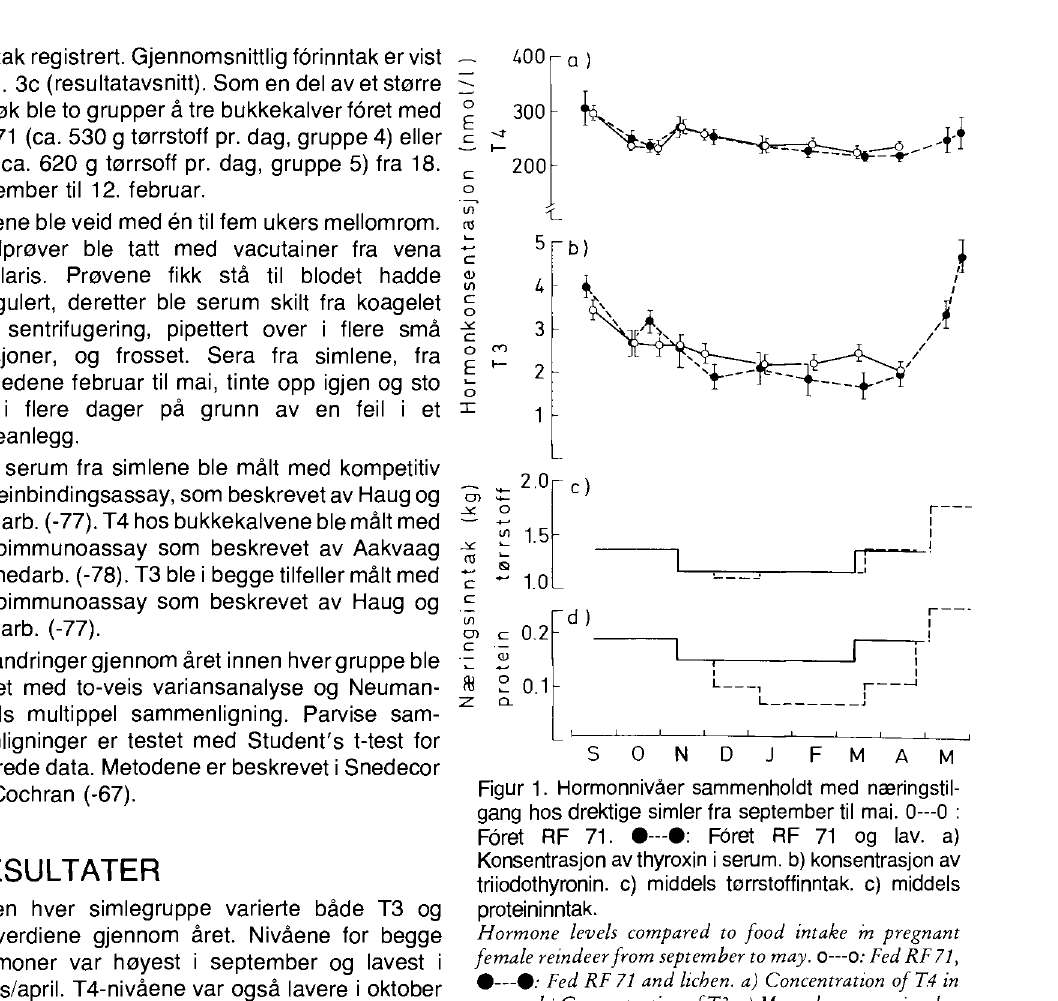
Figur 1. Hormonnivåer sammenholdt med næringstil gang hos drektige simler fra september til mai. 0—0